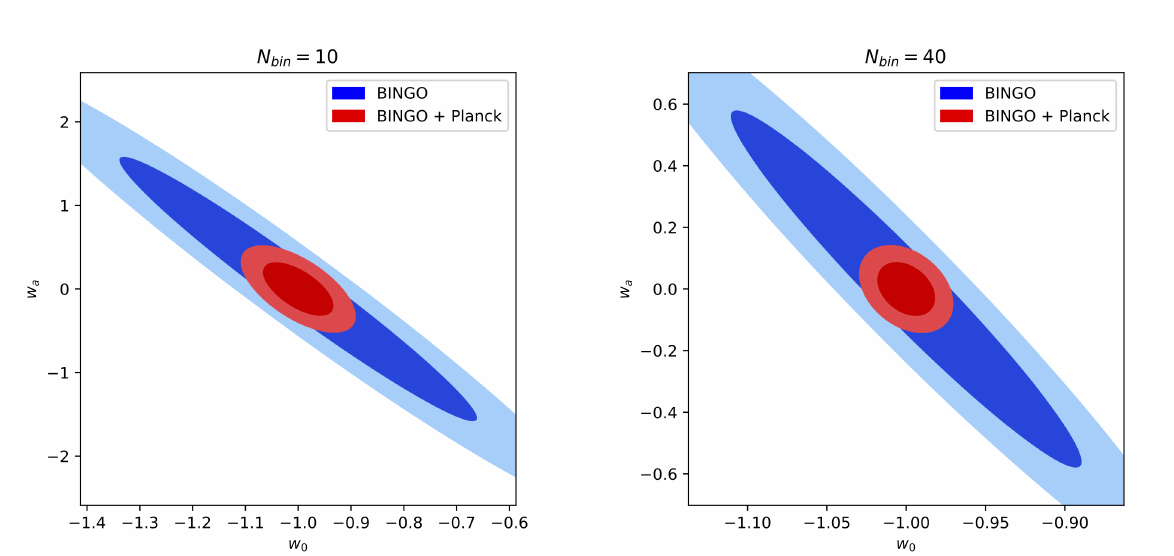
Figure 2. 68% and 95% confidence level constraints on the DE equation of state parameters using BINGO and BINGO + Planck . The results are show for two different number of redshift bins (Costa et al.